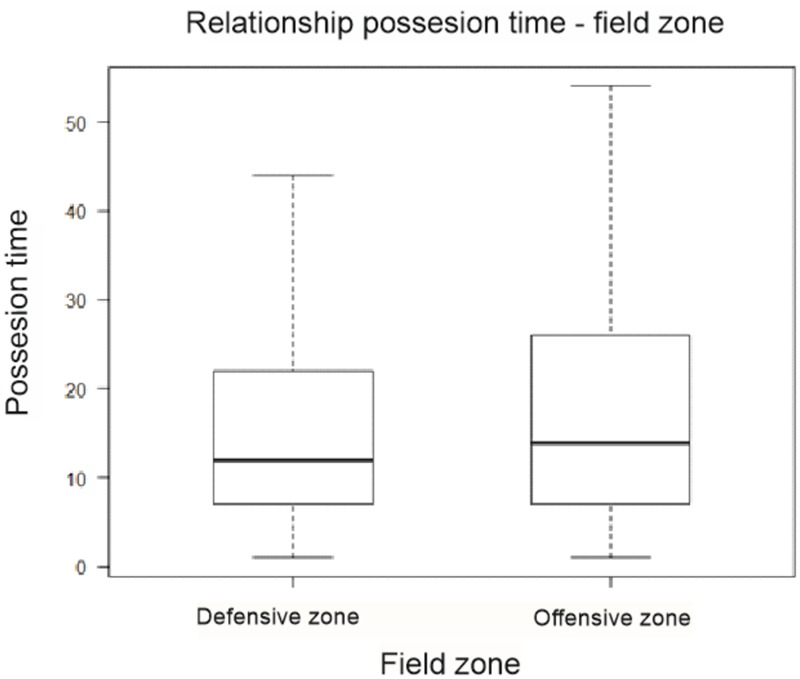
Possession zone (field zone) and possession time diagram box.